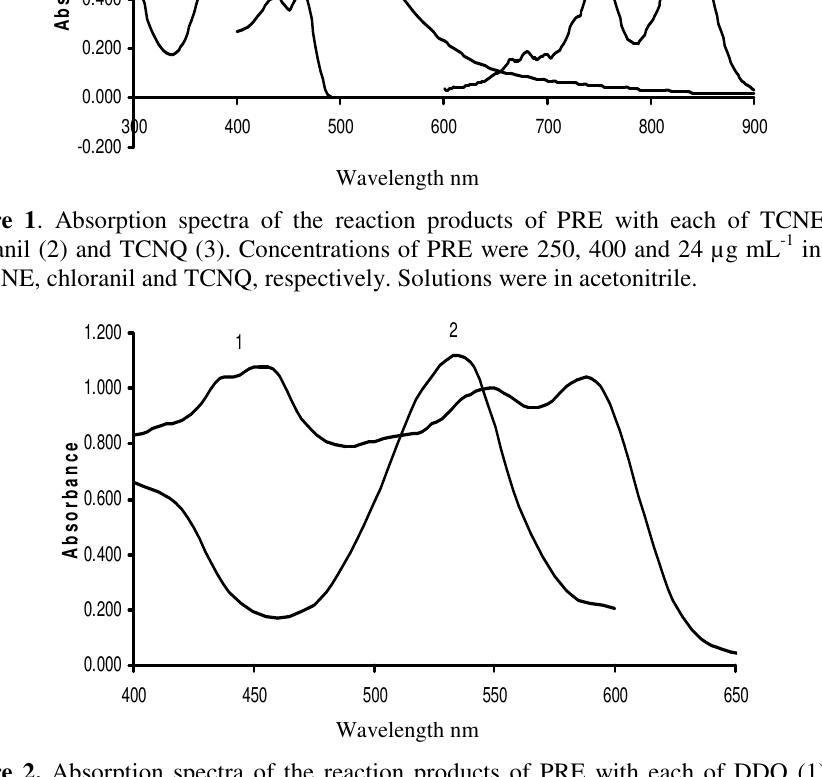
Figure 2. Absorption spectra of the reaction products of PRE with each of DDQ (1) and p CA (2). Concentrations of PRE were 70 and 120 µg mL -1 in case of DDQ and pCA, respectively. Solutions were in case of DDQ methanol and in acetonitrile in case of p